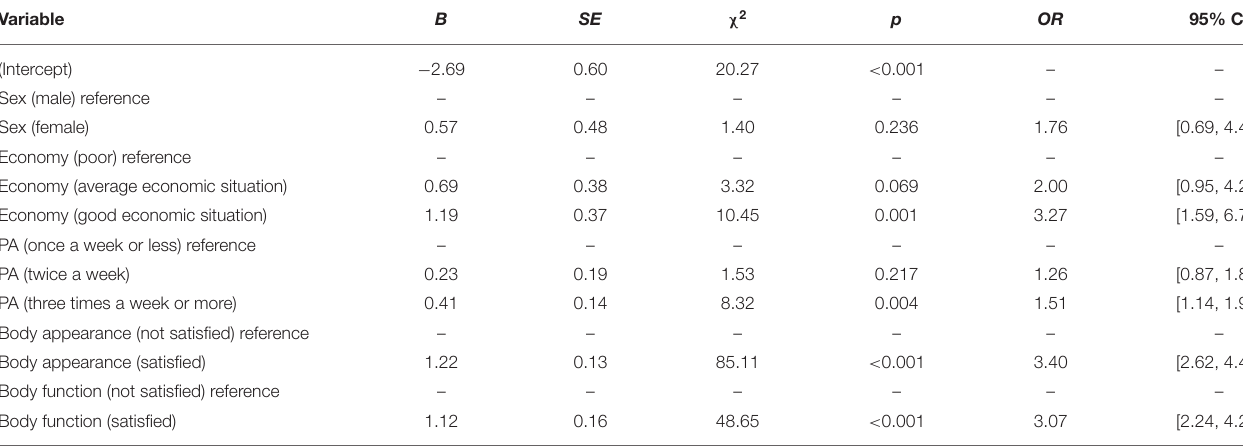
TABLE 4 | Variables associated with good wellbeing in a multiple logistic regression analysis ( n = 1,491).